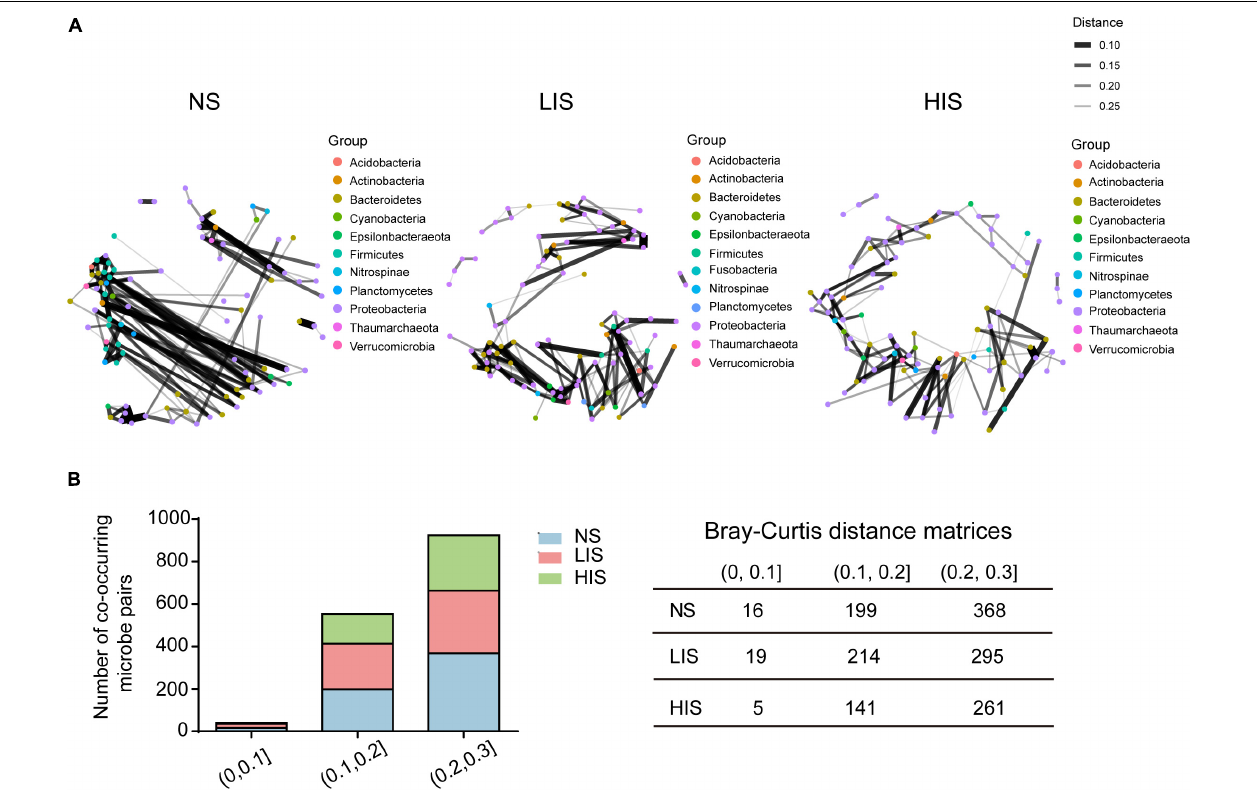
FIGURE 6 | Microbial co-occurrence network of the three study sites. (A) Co-occurrence networks were constructed based on Bray–Curtis distance matrices (for values less than 0.3) based on the relative abundance profiles of genera among the three sites. The smaller the distance is, the stronger the co-occurrence correlation is. Each node represents a genus; genera belonging to the same phylum are shown in the same color. (B) Summary of co-occurring microbe pairs at the three sites under different Bray–Curtis distance